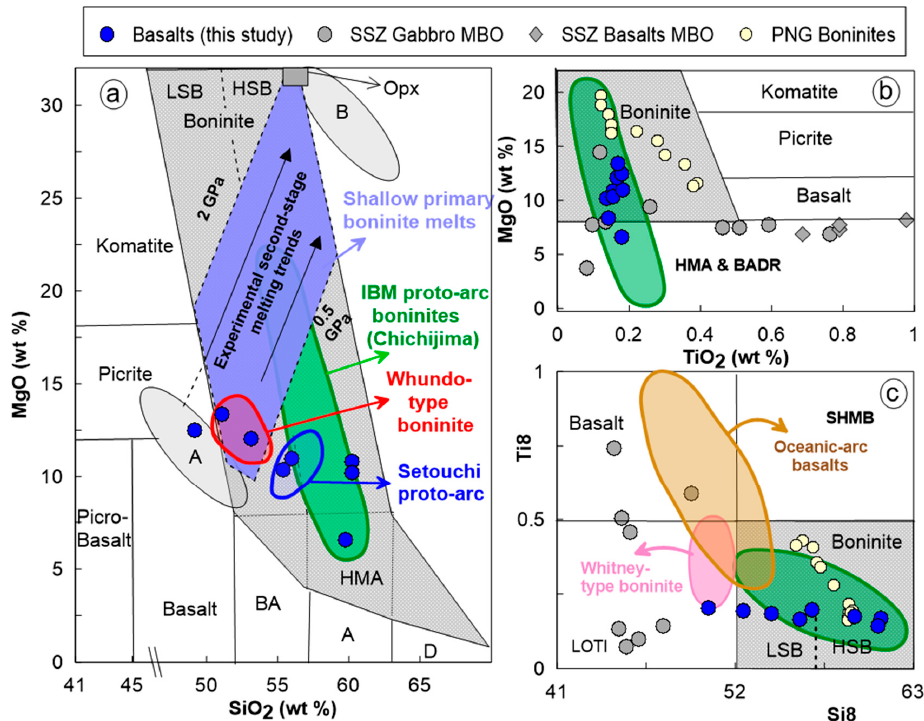
Figure 13. Boninite classification diagrams for identification of basalts. ( a ) MgO vs. SiO 2 ; ( b ) Mgo vs. TiO 2 ; ( c ) Si8 vs. Ti8 projections, respectively. The geochemical boundaries (after Pearce and Reagan [126]) are parallel to fractionation trends of a typical boninite [117]. For references to the experimental data and further details, see Pearce and Reagan [124]. Data from Kakar et al. [4] and König et al. [64] are shown for comparison. Fields of Izu-Bonin-Mariana proto-arc [117], Whundo- type boninite [118,119], Setouchi protoarc [120], Whitney-type boninite [118,121], and oceanic-arc basalts [124] are presented for comparison. Abbreviations; LSB = low-Si boninite; HSB = high-Si boninite; HMA = high-Mg andesite; BA = basaltic andesite; A = andesite; D = dacite; BADR = basalt- andesite-dacite-rhyolite; SHMB = siliceous high-Mg basalts; LOTI = low-Ti